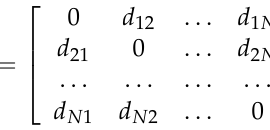
Division of objects into typological groups with similar dynamics of the studied phe- nomenon, using the distance measure based on regression coefficients in exponential models. The distance-based methods between the compared objects can be